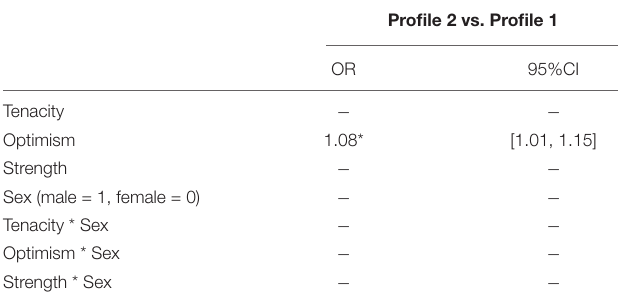
Table 7 presents odds ratios (OR) for binary logistic regression. Profile 1 = constant high negative affect profile; Profile 2 = slowly decreasing low negative affect profile. Profile 1 and males are the reference categories. The non-significant variable and interactionsthatweredroppedfromthefinalanalysisareindicatedbyns;*p < 0.05.